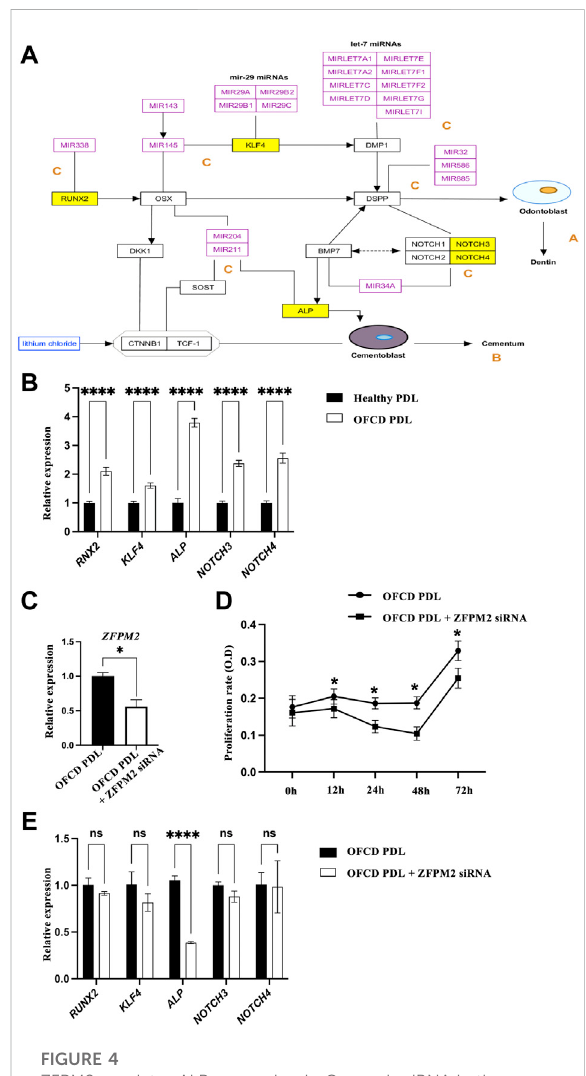
FIGURE 4 ZFPM2 regulates ALP expression in Osx and miRNA in the tooth development pathway. (A) Osx and miRNA in the tooth development pathway. Compared with that in the healthy subject, RUNX2 , KLF4 , NOTCH3 , NOTCH4 , and ALP were considerably elevated in the patient with the OFCD syndrome. A) Osx control of Dspp demonstrates its signi fi cance in dentinogenesis. B) Osx controls cementoblast differentiation via the Wnt- β -catenin pathway. C) Role of miRNAs in fi ne-tuning toothdevelopment.Theyellowboxesindicatetheelevatedsignals above a fold change of 2 in the microarray analysis. (B) The expression of differentially expressed genes was determined using qRT-PCR. ANOVA, **** p < 0.0001. (C) qRT-PCR validation of ZFPM2 suppression in Mut PDL cells. t -test, * p < 0.05. (D) MTT assays showed that Mut PDL cell proliferation was inhibited after ZFPM2 knockdown. Points and bars indicate the means and standard deviations of the triplicate values. ANOVA, * p < 0.05. (E) After ZFPM2 inhibition, mRNA ALP expression was signi fi